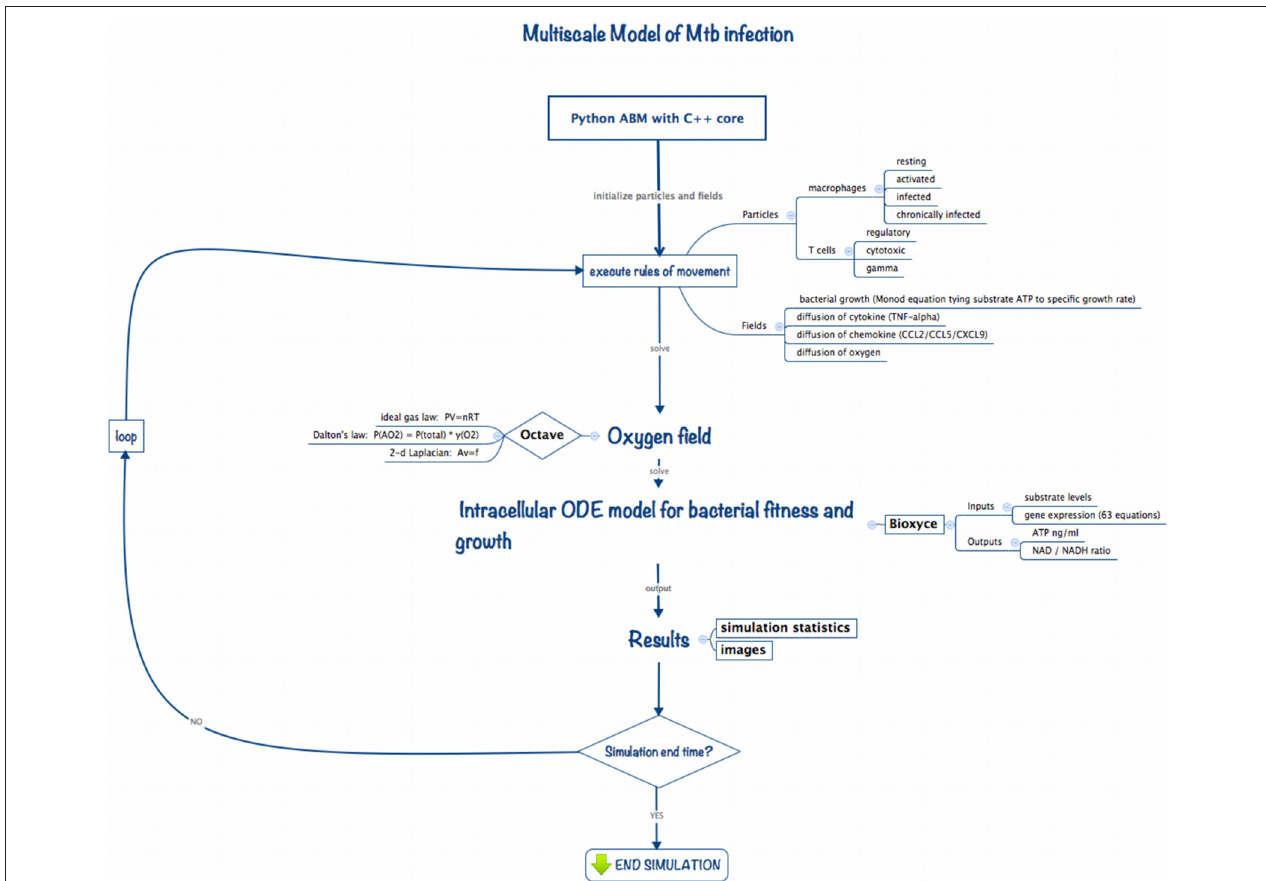
FIGURE 1 | Implementation schema for the integrated multiscale model of Mtb infection.